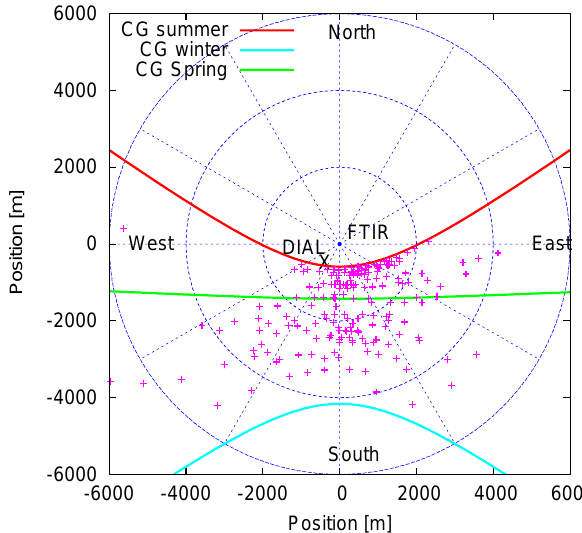
Figure 2. Trajectories of the horizontal positions of the center of gravity (CG) of the vertical water vapor distribution measured by the FTIR for IWV midsummer, spring, and midwinter. Center of gravity horizontal locations from FTIR measurements chronologi- cal coinciding with DIAL measurements ( (cid:49)t ≤ 30min) are marked by